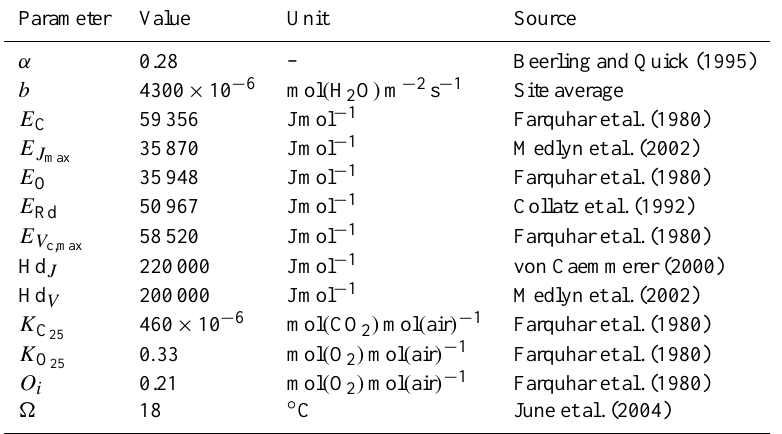
Table 1. Parameters used in the photosynthesis–stomatal conductance model. The offset parameter b was estimated first with an optimisation on the entire data set and then set constant in following model